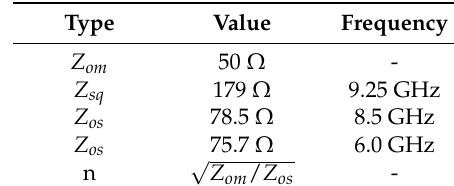
Table 3. Required values for the equivalent circuit model.